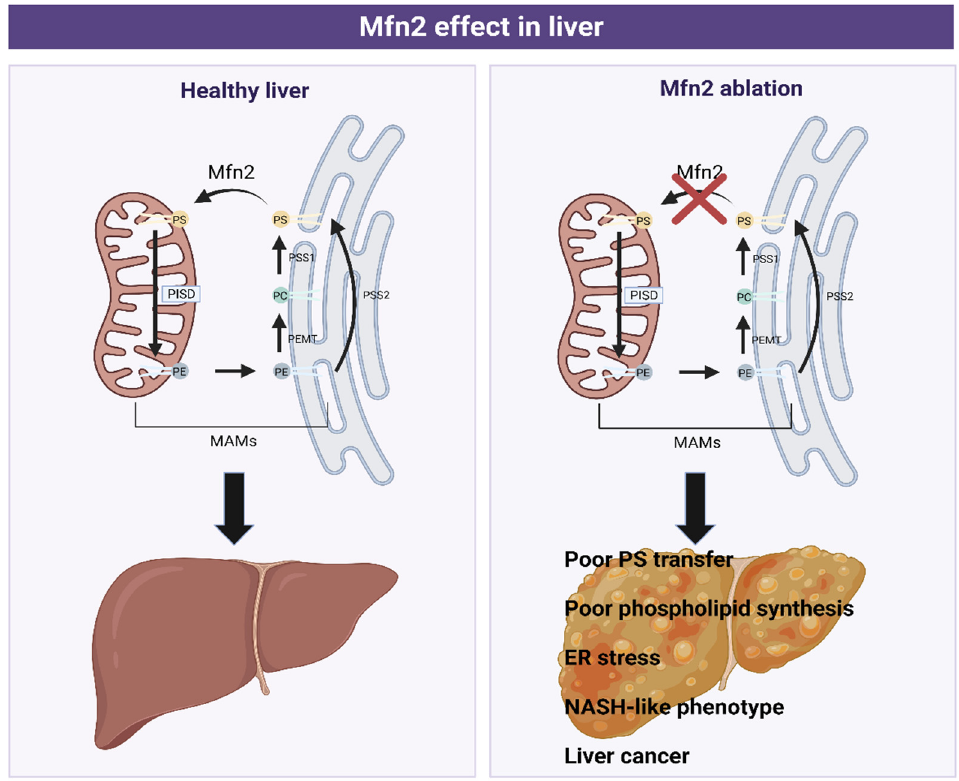
Figure 6. Graphical scheme of phosphatidylserine (PS), phosphatidylethanolamine (PE), and phos ‐ phatidylcholine (PC) synthesis in Mitochondria ‐ Associated Membranes (MAMs) in healthy (left) and pathological (right) liver conditions. Phosphatidylcholine (PC) in the ER is transformed to phos ‐ phatidylserine (PS) (catalyzed by the phosphatidylserine synthase 1 (PSS1)), which is transported to mitochondria by Mitofusin 2 (Mfn2). Here, it is converted to phosphatidylethanolamine (PE) by phosphatidylserine decarboxylase proenzyme (PISD), a protein located in the mitochondrial membrane. PE is then transferred to ER, where is converted to PC or PS, depending on the enzyme implicated, phosphatidylethanolamine N -methyltransferase (PEMT), or phosphatidylserine synthase 2 (PSS2), respectively.